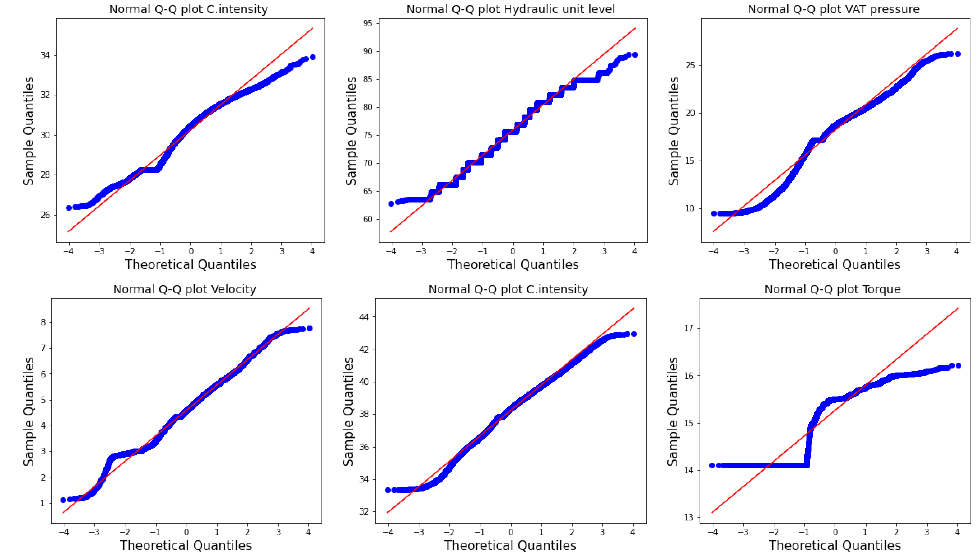
Figure 6. Q–Q plots of the sensor values after data cleaning treatment